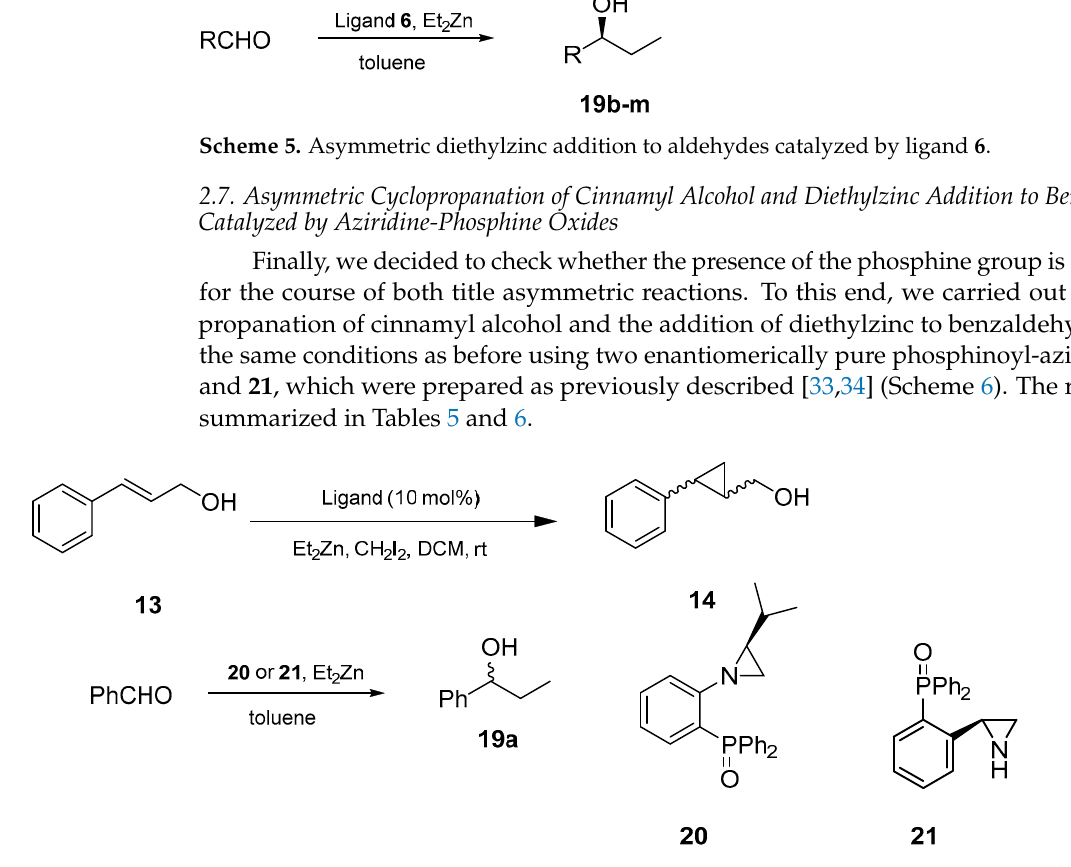
Table 5. Cyclopropanation of cinnamyl alcohol catalyzed by phosphine oxides 20 and 21.